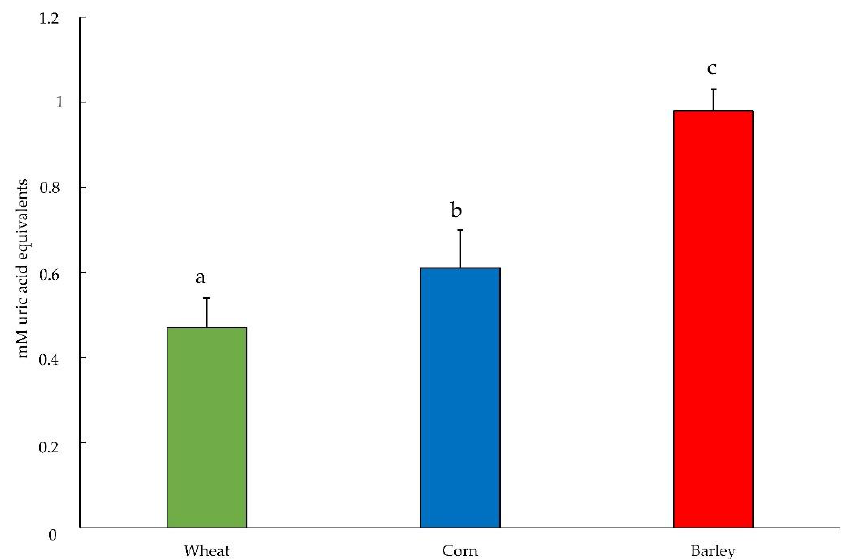
Figure 1. Total antioxidant capacities (in mM uric acid equivalents) of cereal flours (negative controls) measured by OxiSelect™ Total Antioxidant Capacity Assay ( p < 0.001). Different letters above the bars indicate significant differences at p ˂ 0.05.